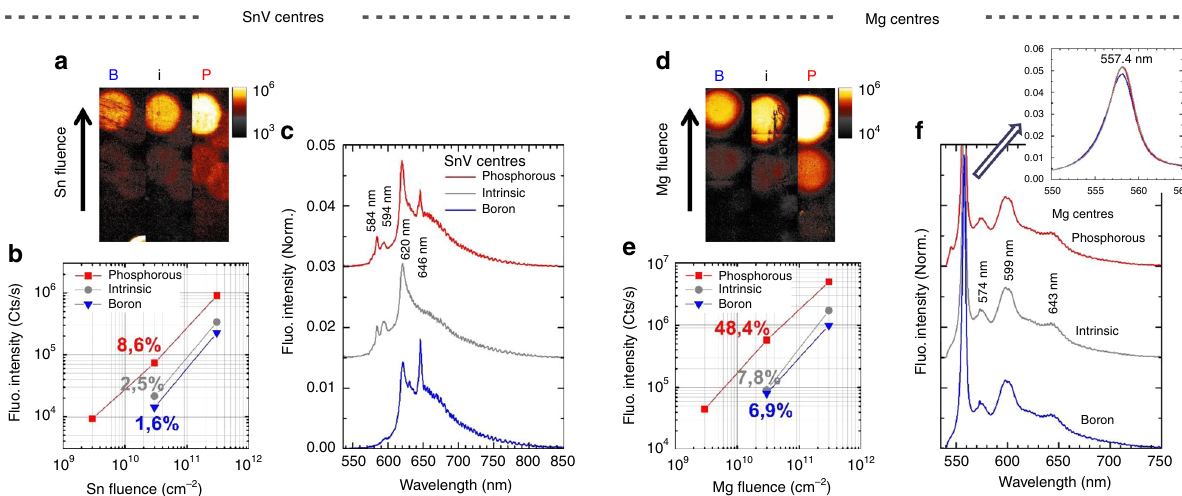
Fig. 4 Doping-dependent SnV and MgV centre formation at 1200 °C. a Confocal fl uorescence scans of the SnV centres implanted in the different doping areas, recorded after the last thermal annealing at 1200 °C for 4 h. The fl uorescence intensity is in logarithmic scale. The laser excitation is 532 nm and the detection with a longpass fi lter 550 nm. b Plot of the fl uorescence intensity vs fl uence, for the different doping conditions. The corresponding creation yields are indicated. c Normalised fl uorescence spectra measured from the different Sn-implanted areas. The spectra are recorded within the 10 × 10 µ m² central region of each implanted spot. The spectra are background corrected (with references taken from 10 × 10 µ m² unimplanted neighbouring areas). d , e , and f , same for Mg-related centres